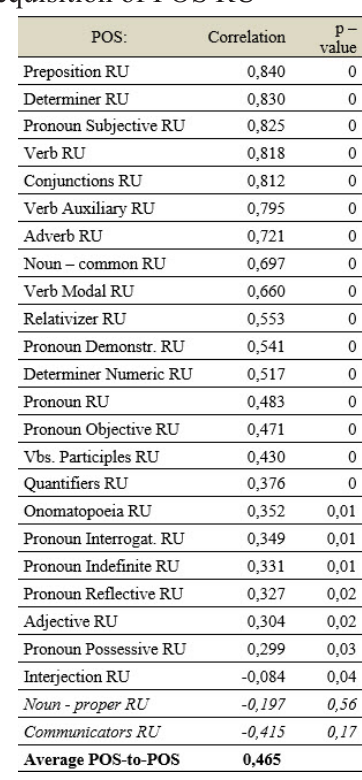
Table 2. Example - expression of